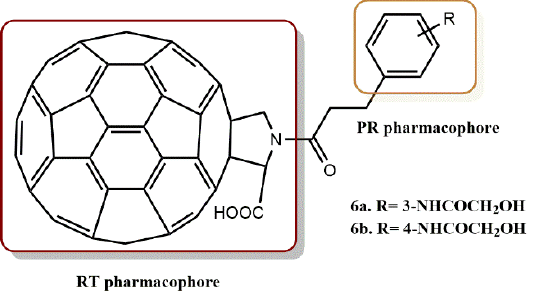
Figure 8. RT and PR pharmacophores of new active synthesized compounds 6a and 6b .